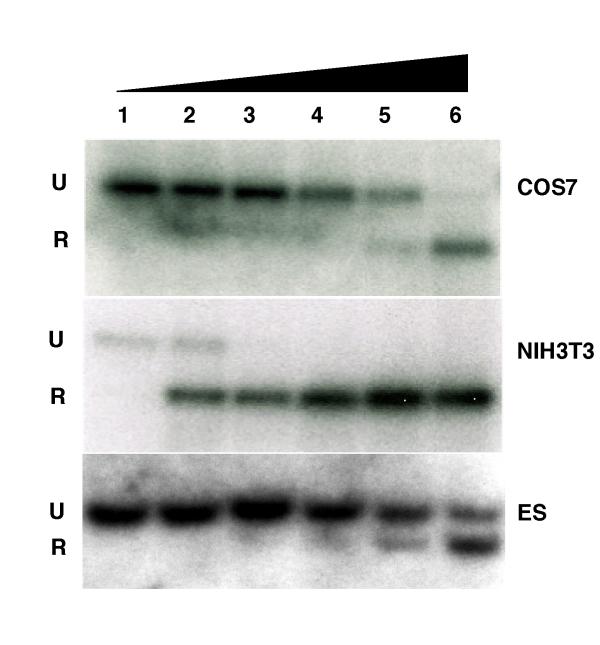
Cre-mediated recombination in different cell types. Cos7 and NIH3T3 cells containing a single integrated copy of the pBABE.lox.stp.EGFP retrovirus and murine embryonic stem (ES) cells containing a floxed IKK γ gene were treated with 0, 0.5, 1.0, 2.0, 5.0, and 10 μM HNC (Cos7 and NIH3T3) or with 0, 0.25, 0.5, 1.0, 2.0, and 5.0 μM HNC (ES cells) for two hours. Cellular DNA was extracted, digested with EcoRI, and analyzed by Southern blot analysis. Cre-mediated recombination results in the conversion of the loxP-containing fragment (upper band, U) to the recombination product (lower band, R).